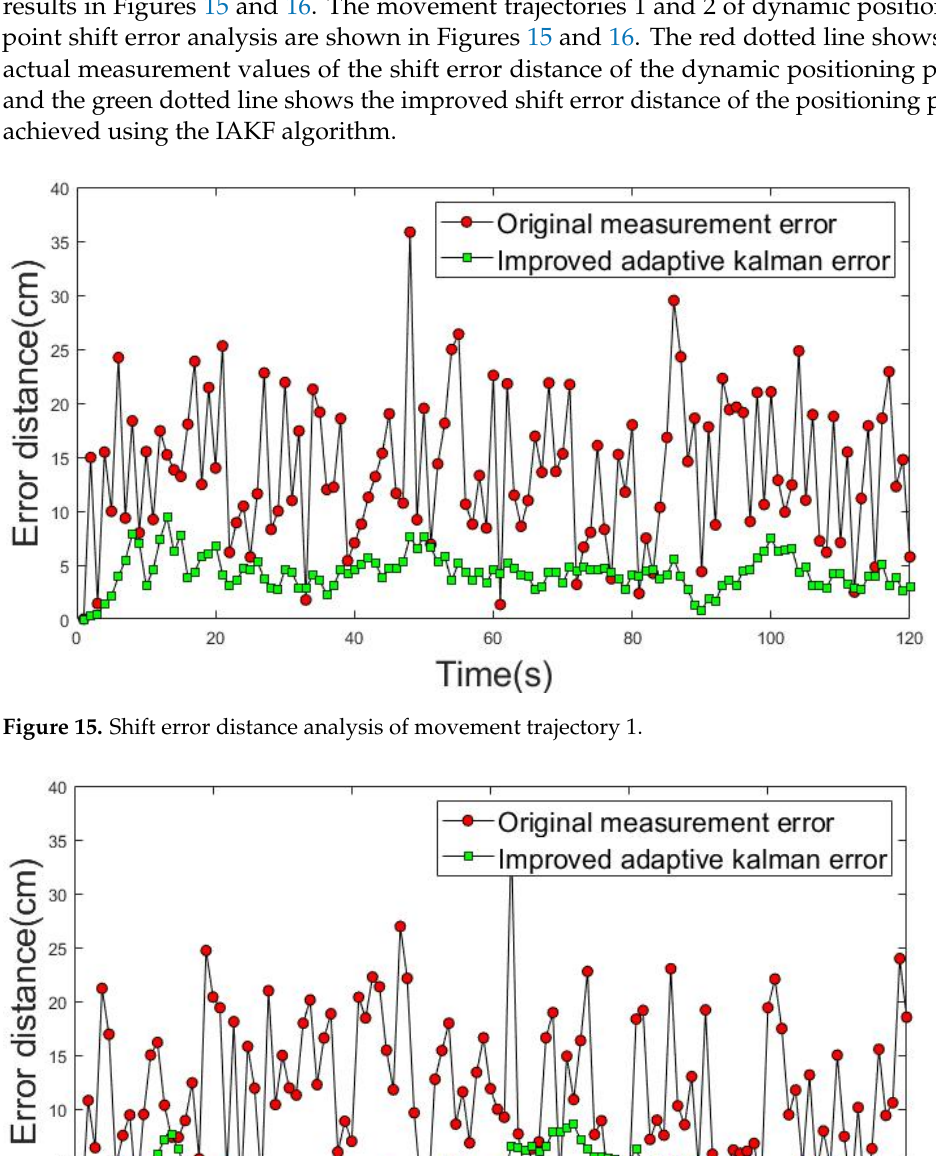
Figure 14. Movement trajectory 2 of tag.